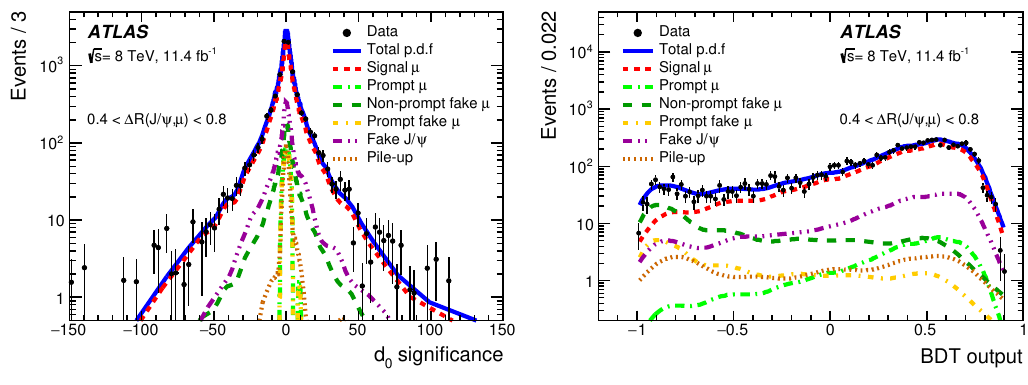
Figure 3 . The two-dimensional S d (left){BDT(right) (cid:12)t for a single di(cid:11)erential observable bin: 0 0 : 4 < (cid:1) R ( J= ; (cid:22) ) < 0 : 8. The points with error bars are data, plotted at bin centres. The solid line is the projection of the unbinned maximum-likelihood (cid:12)t to the data. The signal (cid:22) , prompt (cid:22) , non- prompt fake (cid:22) , prompt fake (cid:22) , fake J= and pile-up contributions are represented by dashed